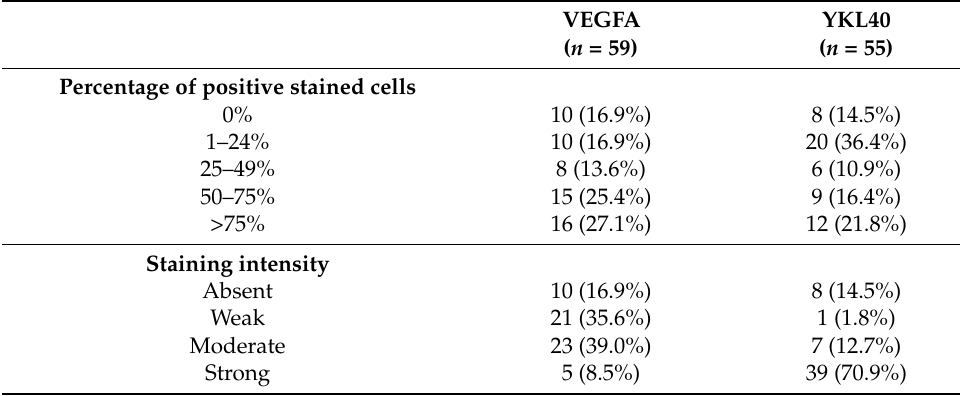
Table 4. Percentage of positively stained cells, staining intensity, and staining score (IHS) of VEGFA and YKL40, evaluated by IHC in GB tumor